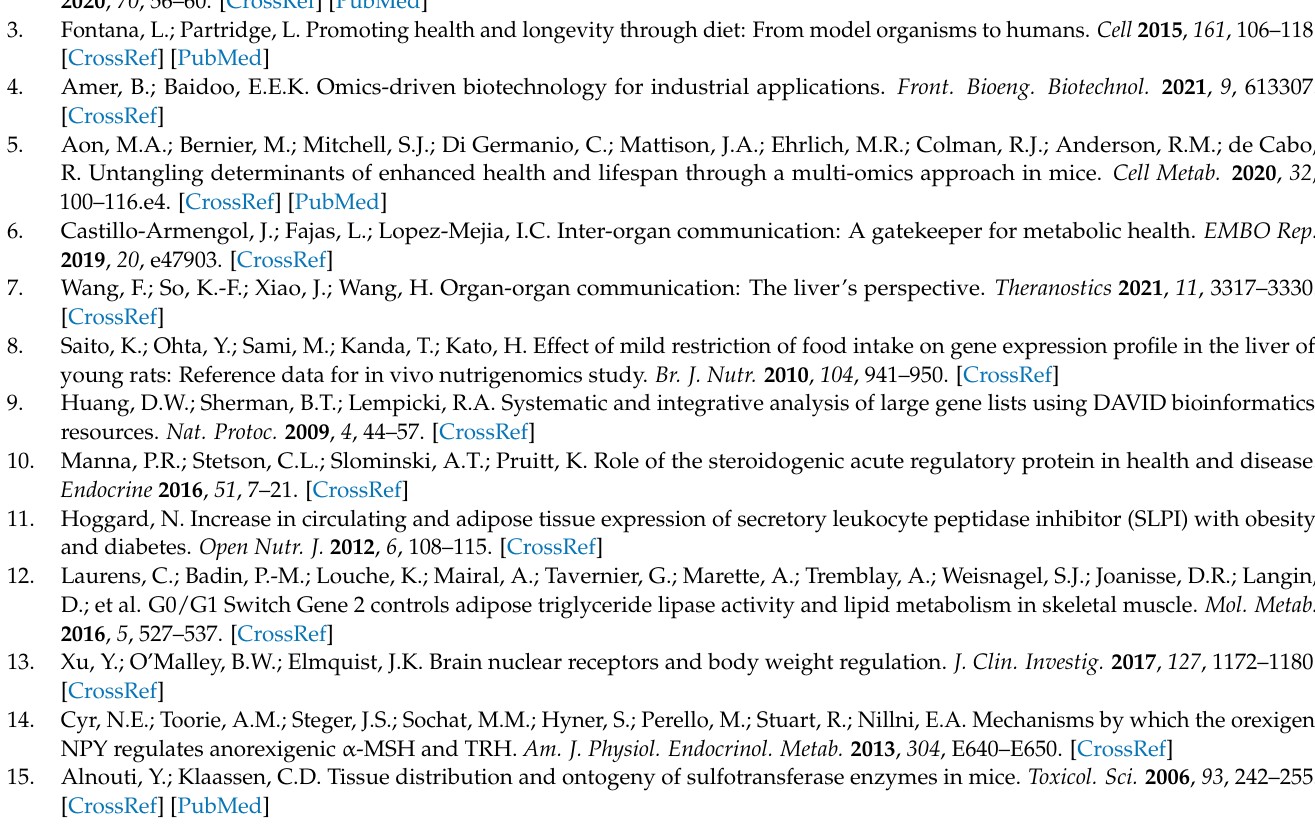
Table S2: GO analysis of the genes up-regulated by 30%CR, Table S3: GO analysis of the genes down- regulated by 30%CR, Table S4: Genes commonly altered by CR, Table S5: Reported meta-analysis of CR transcriptome experiment, Table S6: The comparison of the top five genes consistently up- or down- regulated for each organ with meta-analysis